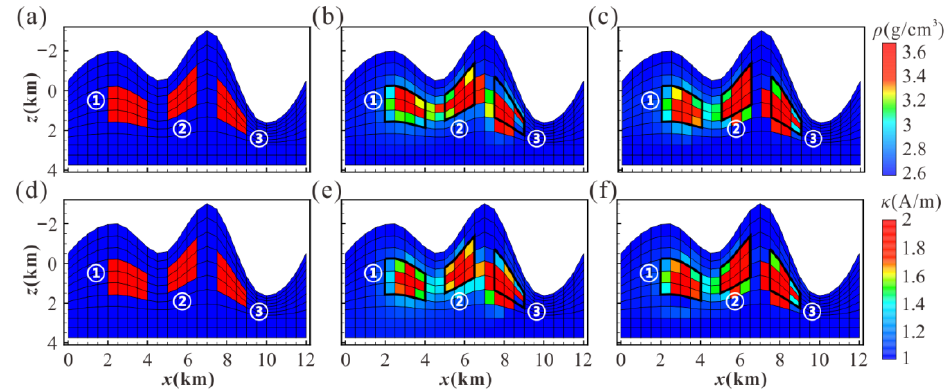
Figure 17. RMSd of inversion. ( a ) RMSd of gravity; ( b ) RMSd of magnetic.